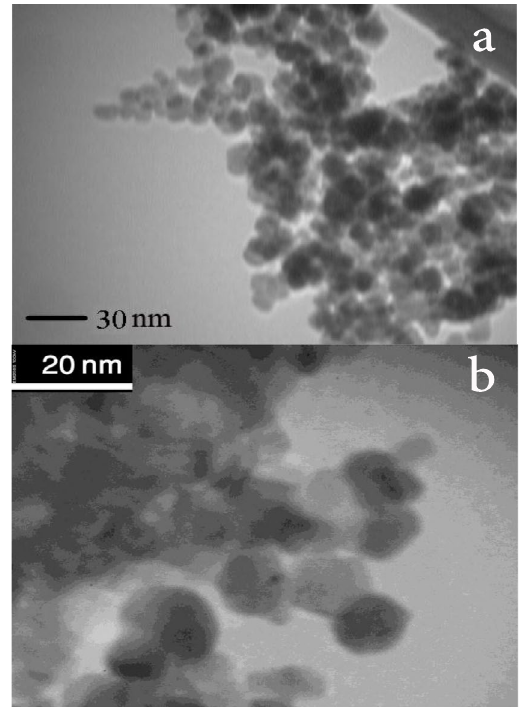
Fig. 3. TEM images of (a) APTS coated MNPs and (b) the na- no-carrier.